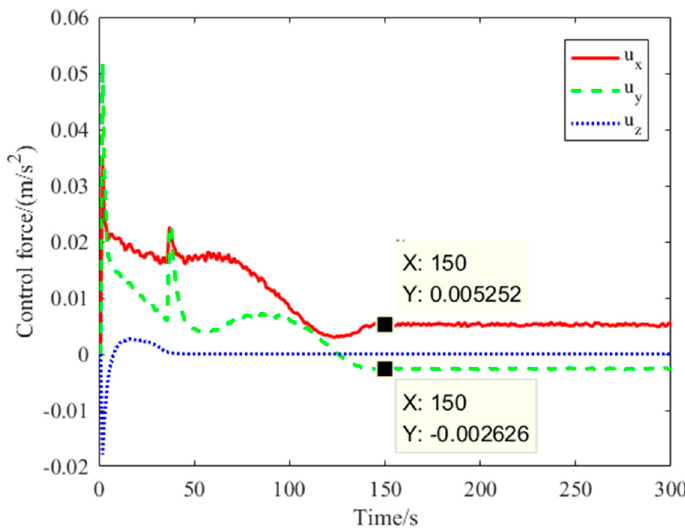
Figure 9. Time response of control force u .